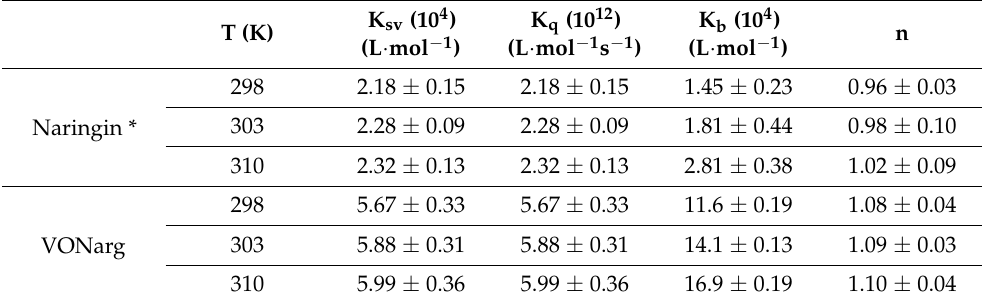
C 6 H 4 CH 2 NH(Et)(Narg)] complexes at 298 K.